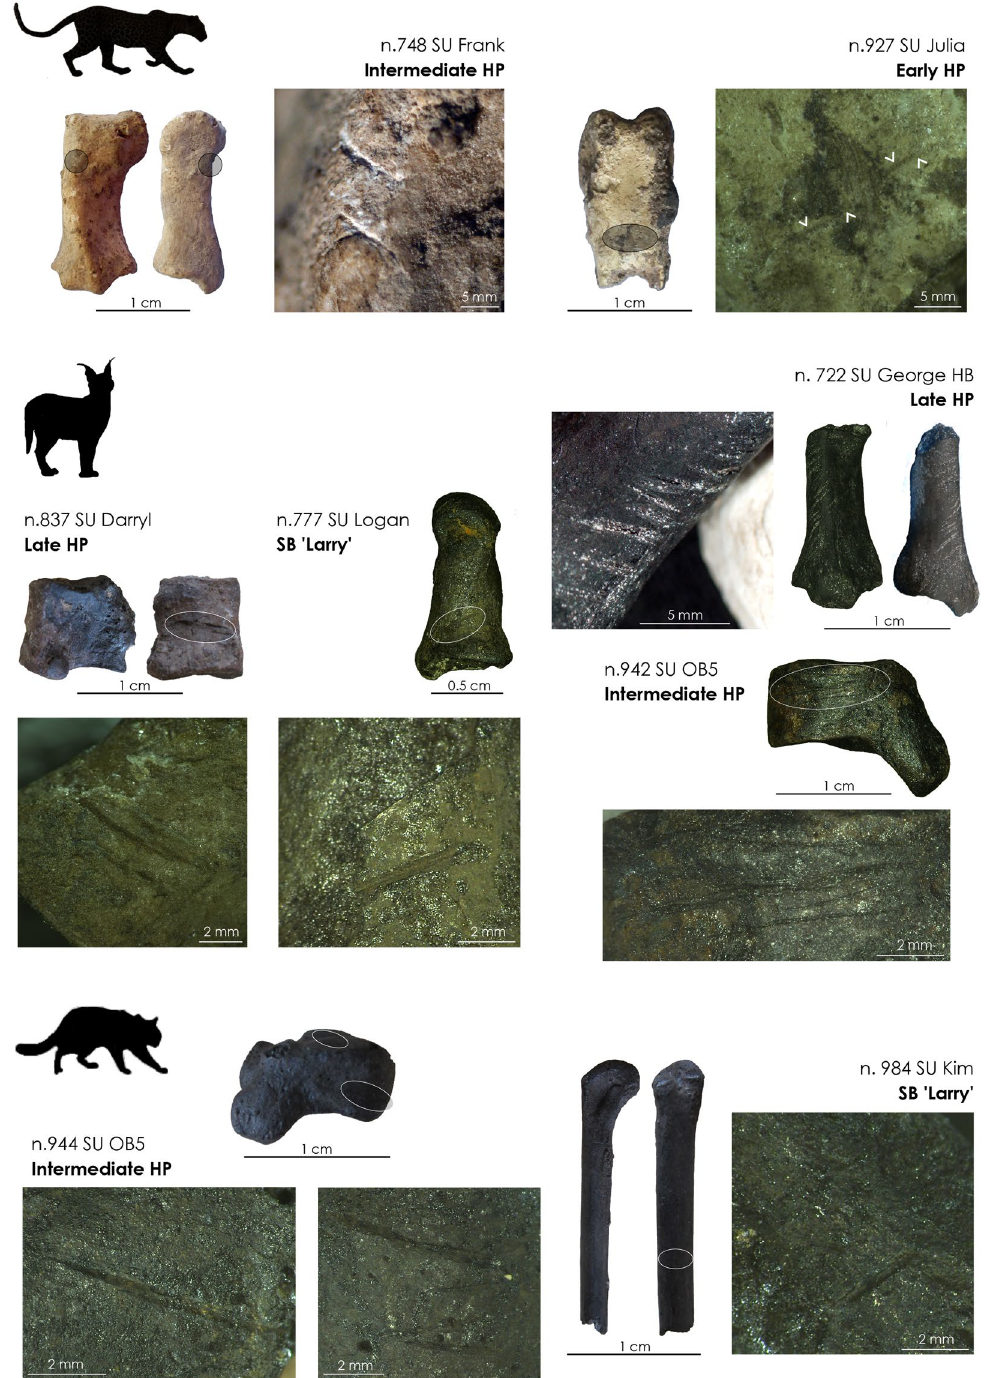
Figure 4. Examples of leopard, caracal/serval and African wild cat cut-marked metatarsals, tarsals and phalanges retrieved from Still Bay (SB) and Howiesons Poort (HP) stratigraphic